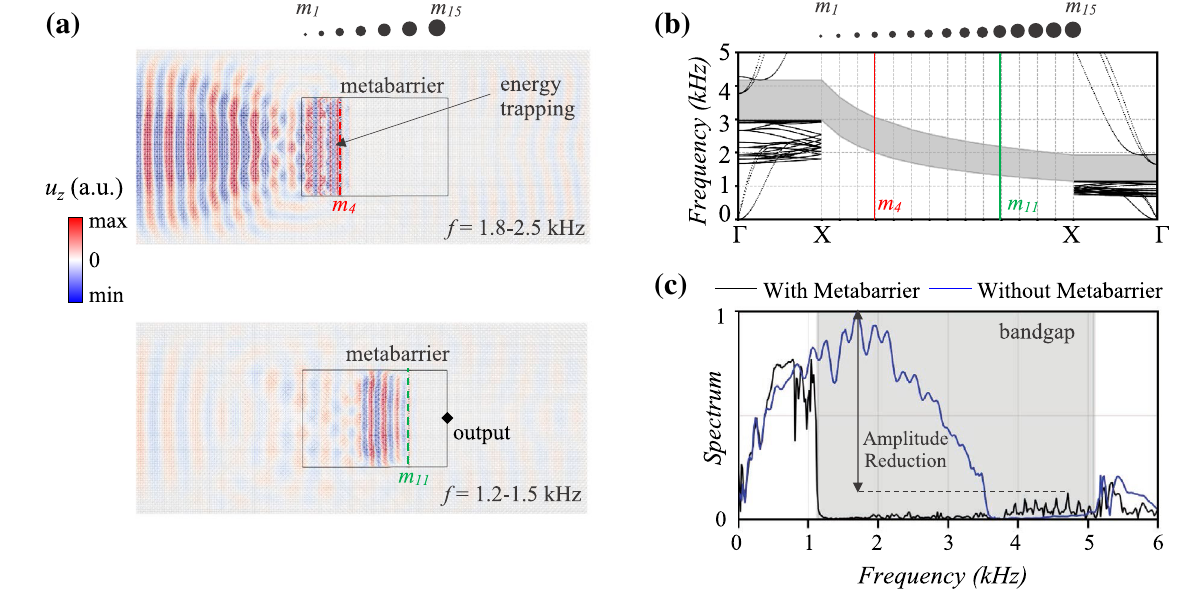
Figure 5. Temporal and spectral wave fields of the graded metabarrier. ( a ) The top and bottom insets show the displacement field filtered within the bandgaps induced by octets with masses m 4 = 11 m ref (red) and m 11 = 31 m ref (green). ( b ) Evolution of the bandgap within the graded metabarrier, for masses increasing from m 1 to m 15 , computed via Bloch analysis (see "Methods" section). ( c ) The spectrum of a signal recorded on the right end of the metabarrier (black), in the output point emphasized in ( a ), is compared with that of a receiver located at the same position in a bare lattice plate (blue). The bandgap generated by this graded design is highlighted in gray. The amplitude reduction within the bandgap is estimated as the difference between the maximum spectrum of the two signals in the attenuation zone, as illustrated in the